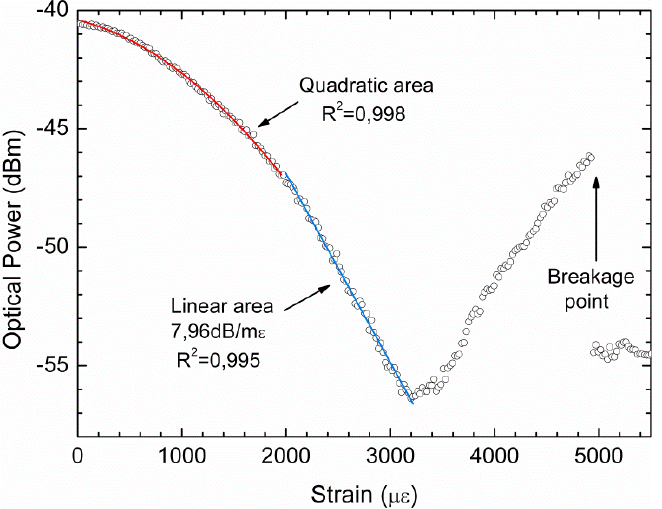
Figure 6. Measured optical power variation with